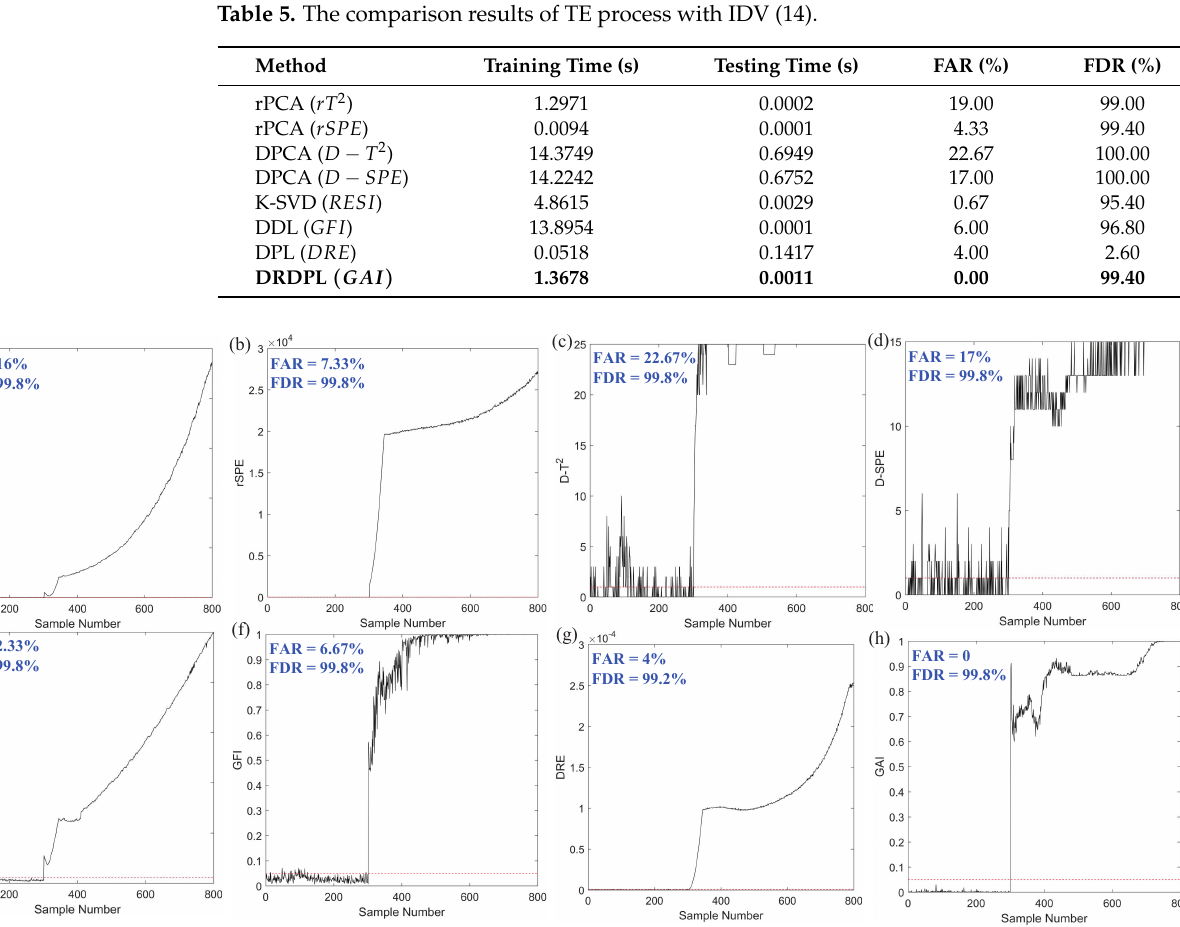
Figure 8. The process monitoring results of TE process with IDV (6). ( a ) rPCA- rT 2 ; ( b ) rPCA- rSPE ; ( c ) DPCA- D − T 2 ; ( d ) DPCA- D − SPE ; ( e ) KSVD- RESI ; ( f ) DDL- GFI ; ( g ) DPL- DRE ; ( h ) DRDPL- GAI